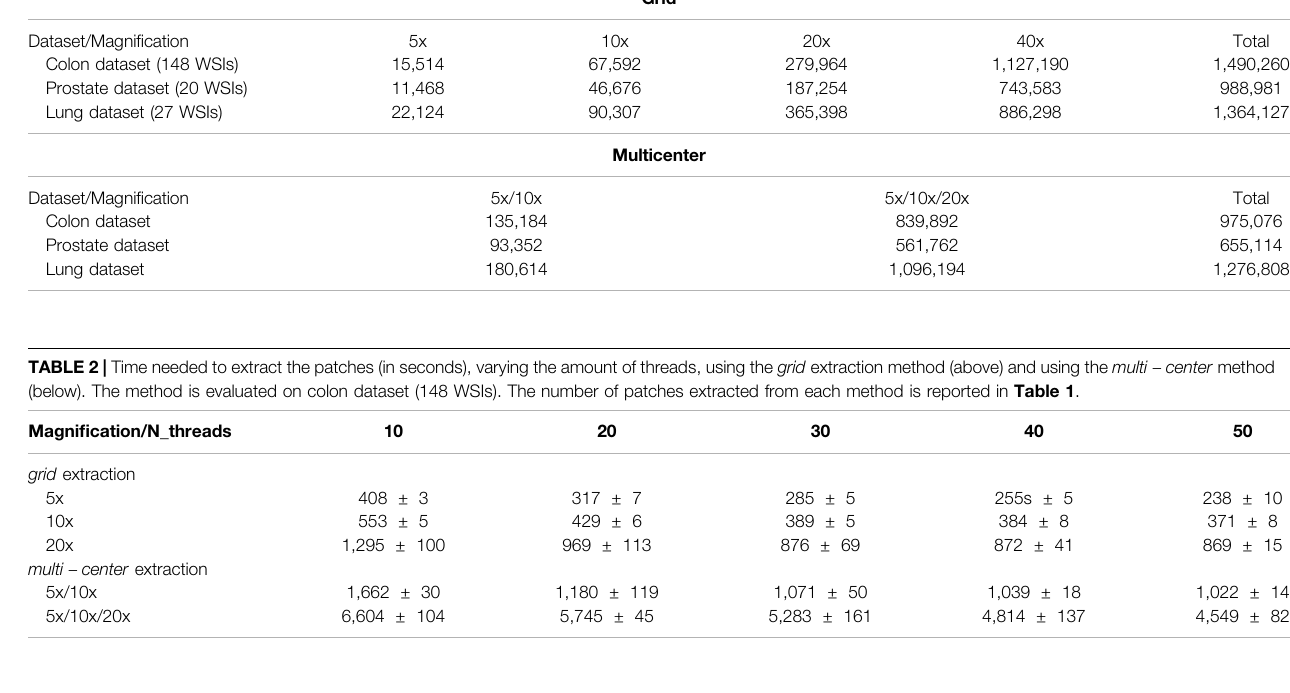
(cid:129) Multi-scale CNN for segmentation, Sub- section 3.4 (cid:129) Library organization, Sub- section 3.5